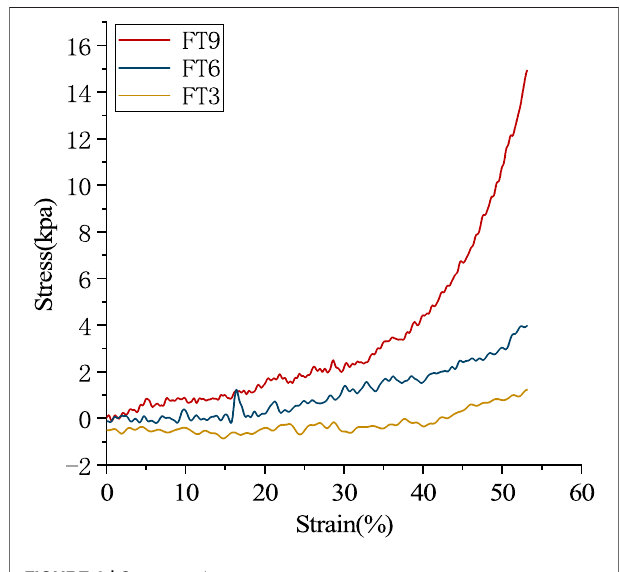
FIGURE 6 | Stress – strain